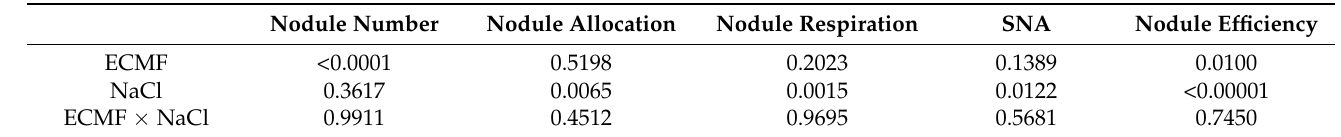
Table 2. p values from least squares models of the effect of ECMF and salt exposure on nodule number, biomass allocation to nodules, nodule respiration, specific nodule activity (SNA), and nodule